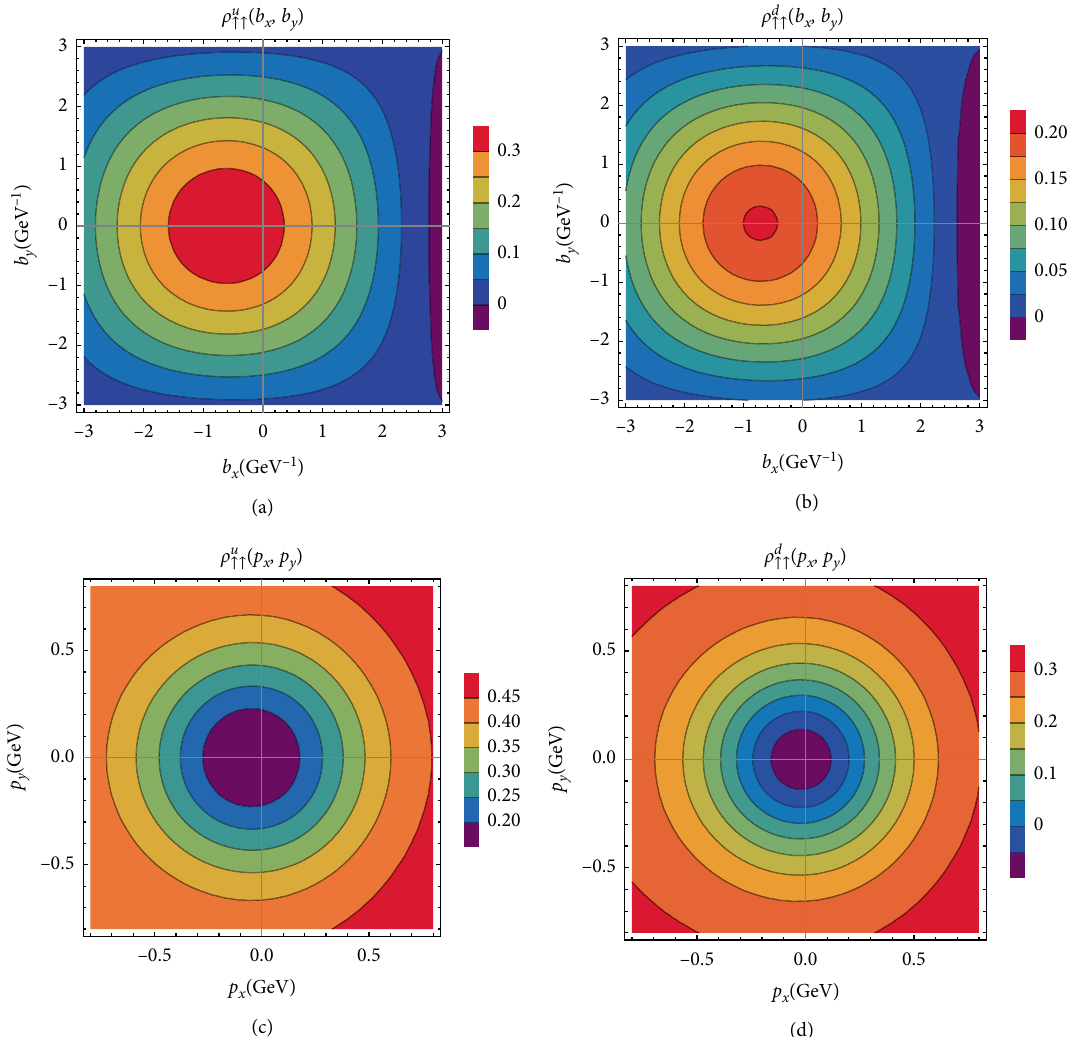
( b , p ) in transverse impact-parameter plane and transverse momentum plane for 𝑢 -quark ↑↑ ⊥ ⊥